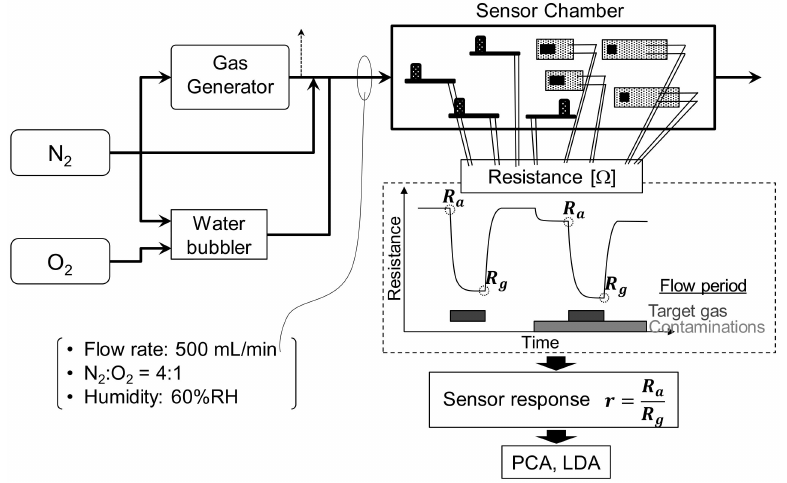
Figure 3. Schematic of flow apparatus for measuring sensor